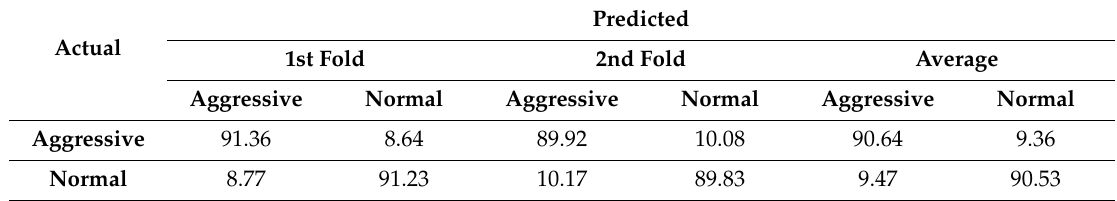
Table 13. Classification accuracies of previous method [53] on Open Database [69] (%).